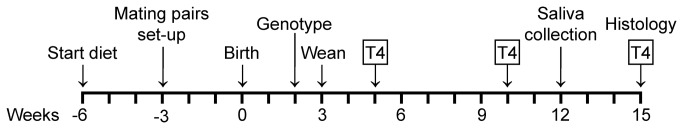
Schematic diagram of thyroid hormone rescue protocol and timing of experimental endpoints.Sexually mature Tpst2+/- males and females were conditioned to control chow or chow supplemented with thyroid powder for 3 weeks. Mating pairs were then established and continued on the control or experimental diet throughout pregnancy. Weanlings were then placed on the same diet until they were sacrificed at 15 weeks of age. All animals were weighed weekly and serum total T4 levels were determined at 5, 10, and 15 weeks of age. Saliva was collected at 12 weeks of age and animals were sacrificed at 15 weeks of age for histological analysis. Groups of 10-13 animals of each genotype (Tpst2+/+, Tpst2+/-, Tpst2-/-) and sex were included in the study.